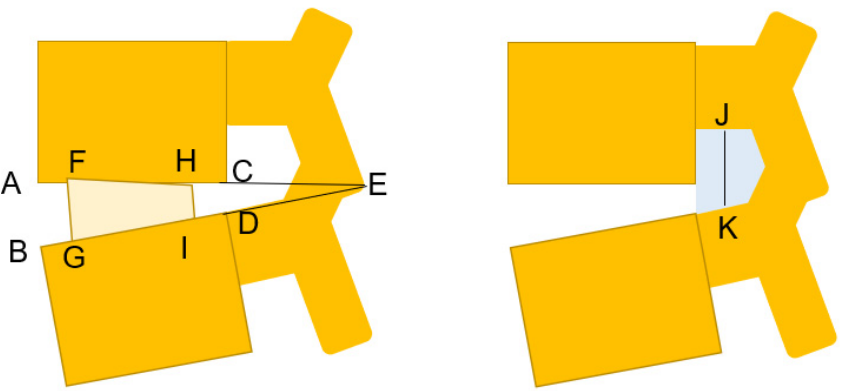
Figure 3. Radiological measurement. Disc height = (AB + CD)/2; segmental lordosis = angle AEB; cage height = (FG + HI)/2; CH—preoperative disc height = (FG + HI) − (AB + CD); foraminal height = JK; foraminal area = gray area. A: Antero-inferior corner; C: postero-inferior of the upper vertebra; B: antero-superior corner; D: postero-superior corner of the lower vertebra; J: center of the lower pedicle cortex; K: center of the upper pedicle cortex.